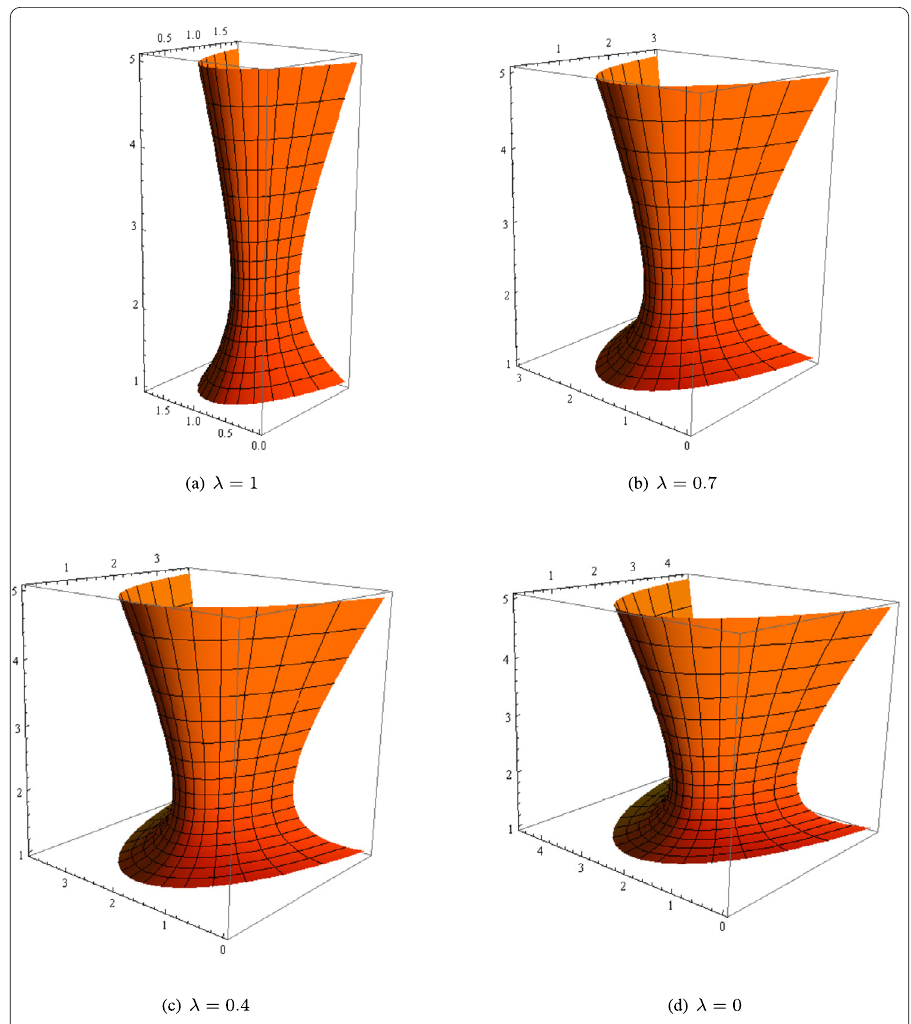
Figure 13 Cubic GBT-Bézier swung surfaces designed with different scaling factor